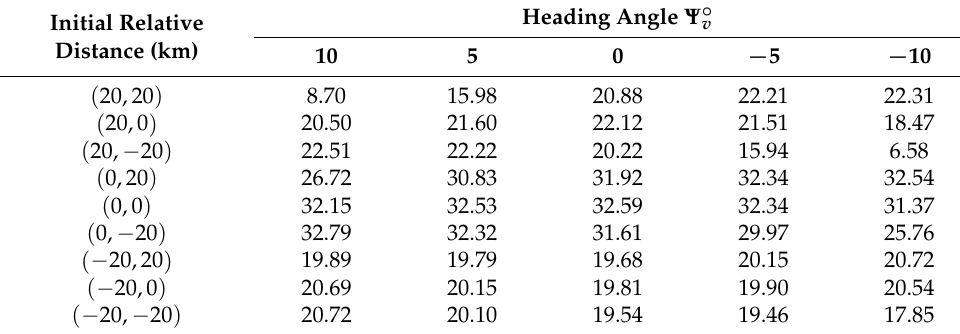
Table 9. Miss distance (m) with initial flight path angle θ = − 10 ◦